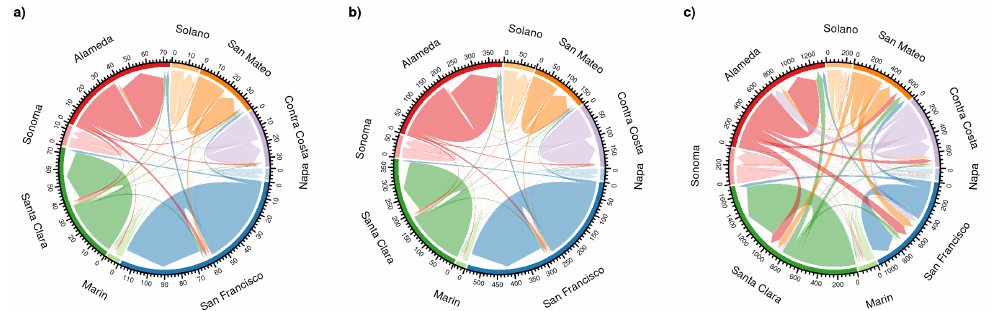
Figure 7. Chord diagrams for County-level connections of ( a ) Twitter flows during rush hours, ( b ) Twitter flows outside of rush hours and ( c ) LODES data (magnitude × 1000).